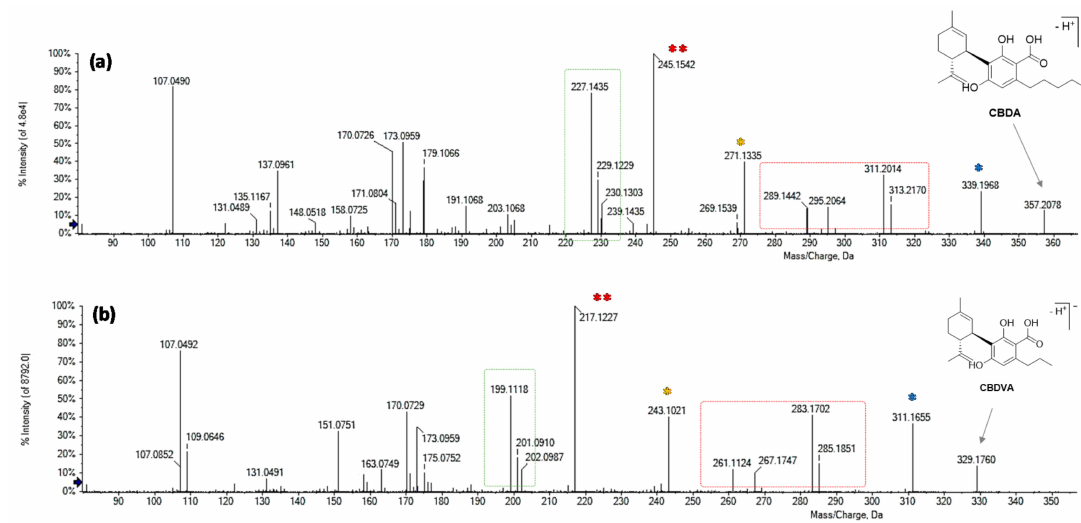
Figure 5. TOF-MS 2 spectra of ( a ) CBDA and ( b ) putative CBDVA. Fragment ions deriving from the same neutral losses are marked with the same symbol.